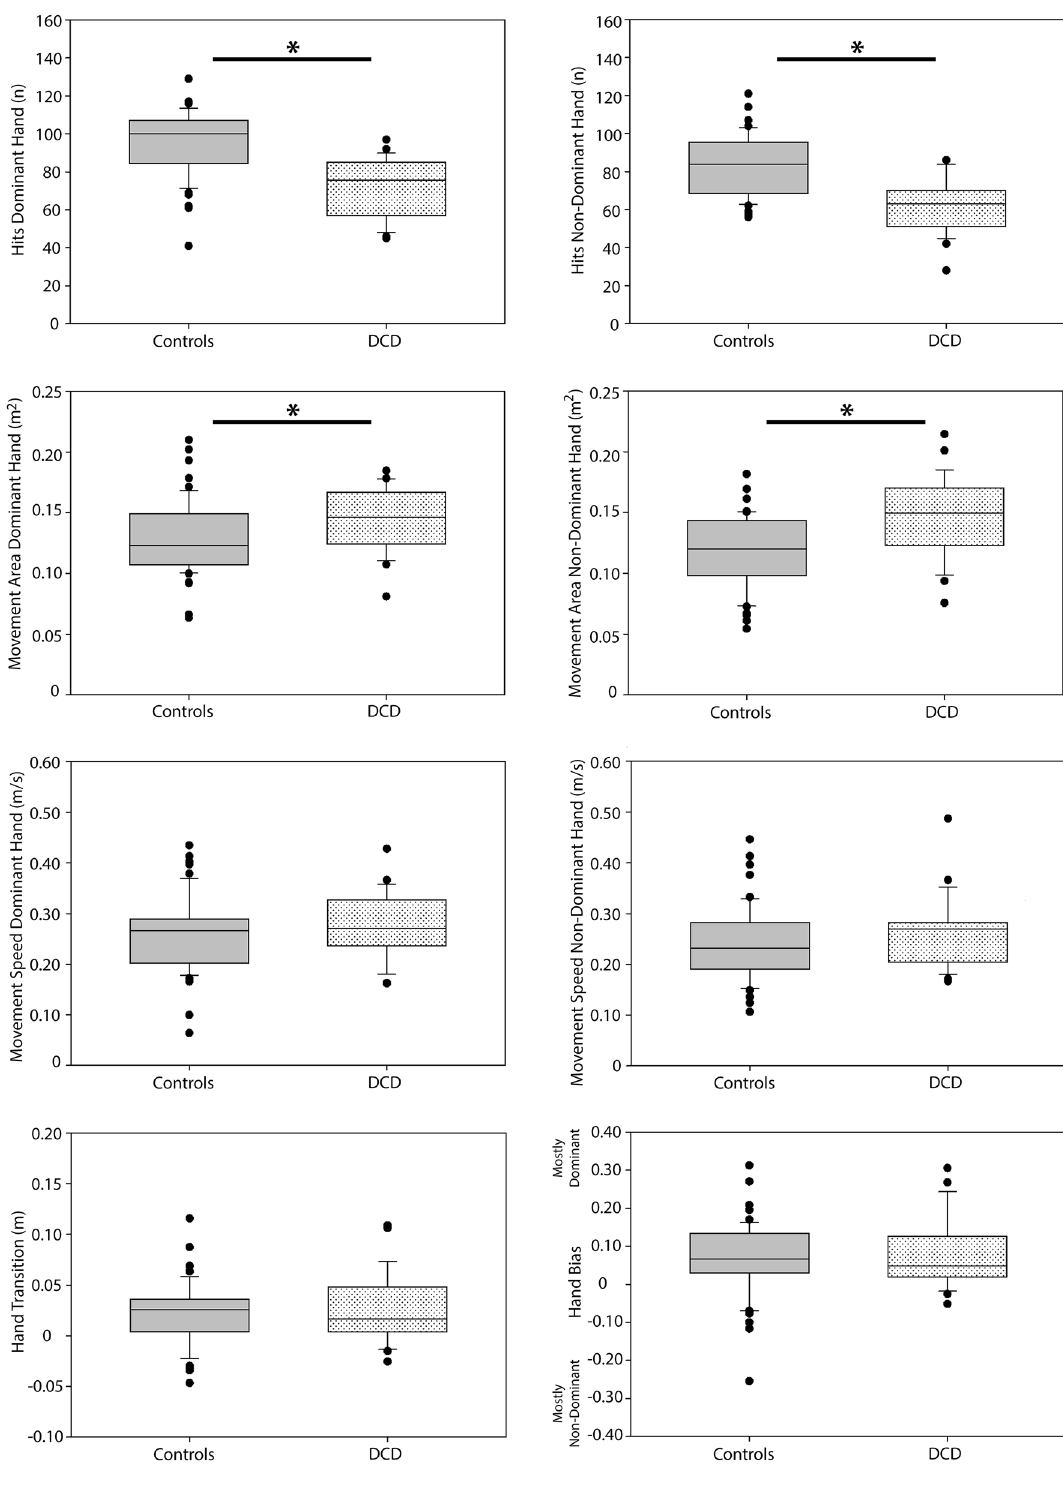
Figure 6. Group differences in performance on the bimanual object hitting task. Box plots are shown for both the dominant and non-dominant arms. *p <